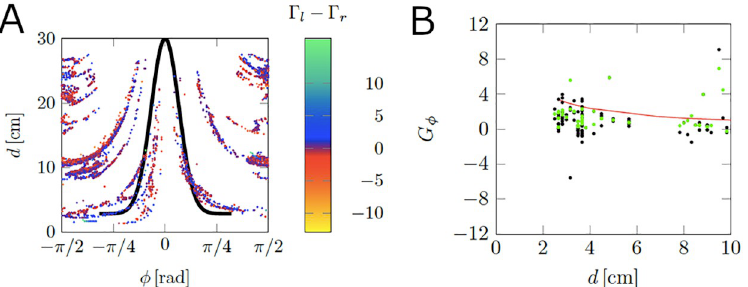
Fig 7. Illustration of the wall calibration process. (A) Two-dimensional projection of the difference of vortex strengths Γ , as a function of the projected distance, d , and angle to collision, φ , for one trial from Bright. The l − Γ r black curve is a normal function utilized to select relevant values of ( φ , d ) associated with those instances when the fish turns according to the angle to collision ϕ . (B) Example of calibration of the wall function. Black dots correspond to G and green dots correspond to the filtered output of | G ϕ |. The red line is the fitted wall function.